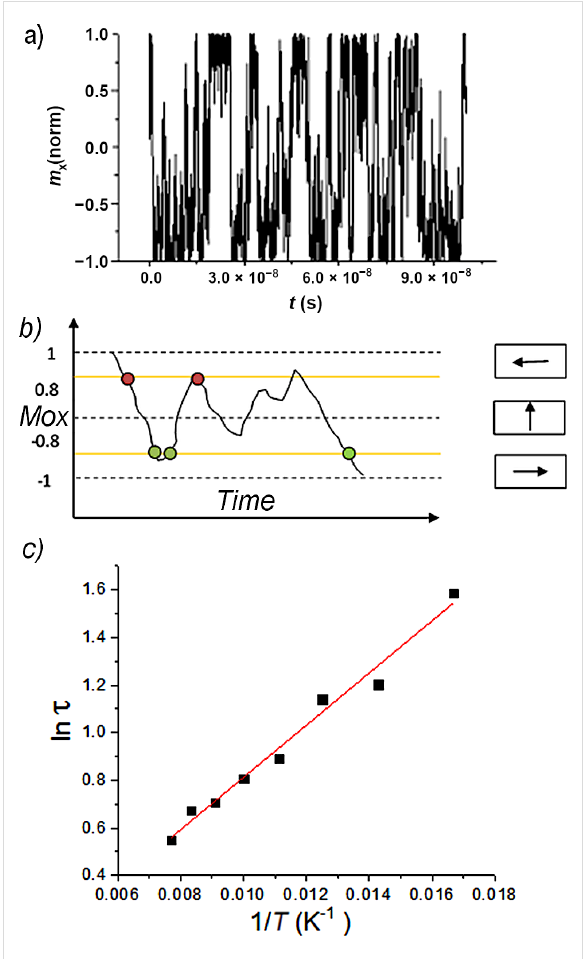
Figure 4: Temporal evolution of normalized magnetization along the Ox axis for particle P1 within a high volumetric fraction configuration, at 60 K (a). Counting method for the random switching of normalized magnetization (b). Arrhenius plot for the same particle, in the same configuration for temperatures ranging from 60 K to 140 K